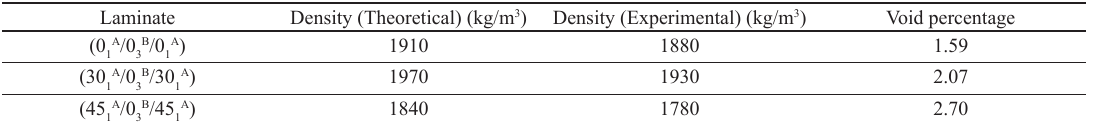
Table 2. Void percentage of composites.